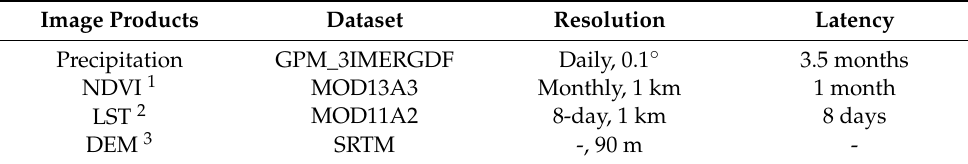
Table 1. All the image products used in the study. Image Products